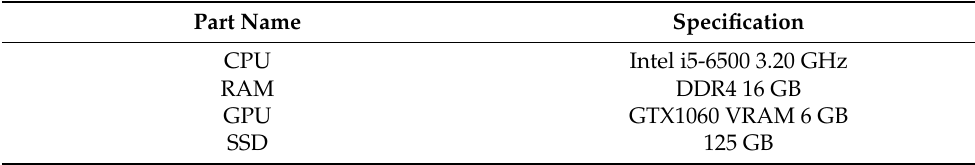
Table 6. The hardware environment used for simulation.